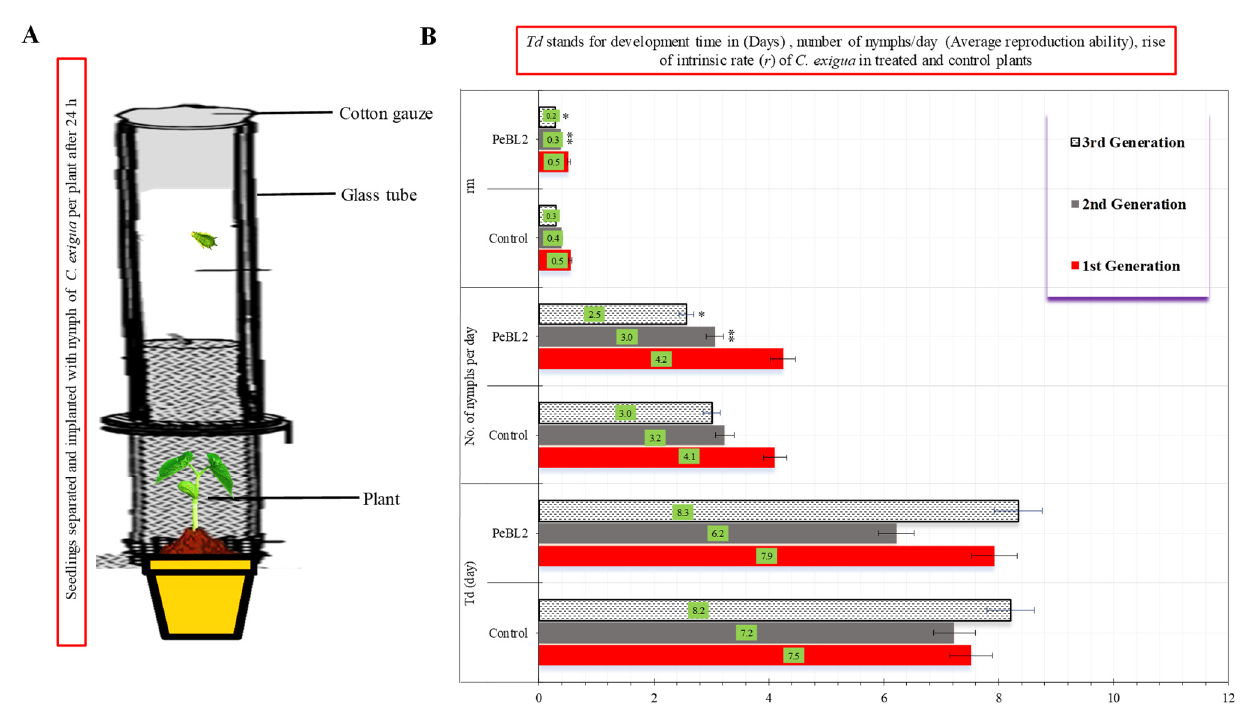
Figure 3. Development time, reproductive capacity, and rate of growth of C. exigua ( A , B ) in seedlings treated with PeBL2 and control (mean ± SD). The study used a randomized (CRD) statistical design, and SPSS 18.0 was used to compare data by LSD and one-way ANOVA ( p = 0.05). An asterisk on the bar shows a significant difference from the buffer control as found by students t-test (* p < 0.05 and ** p < 0.01)